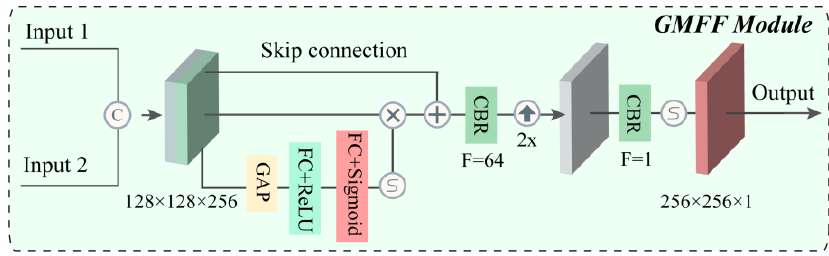
Figure 5. Illustration of the gated multilevel feature fusion (GMFF) module.